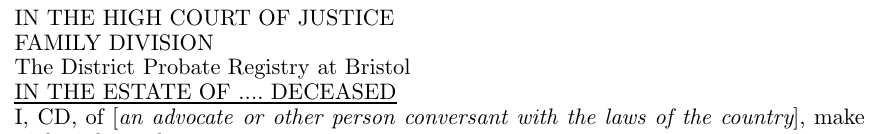
The precedent of an affidavit IN THE HIGH COURT OF JUSTICE FAMILY